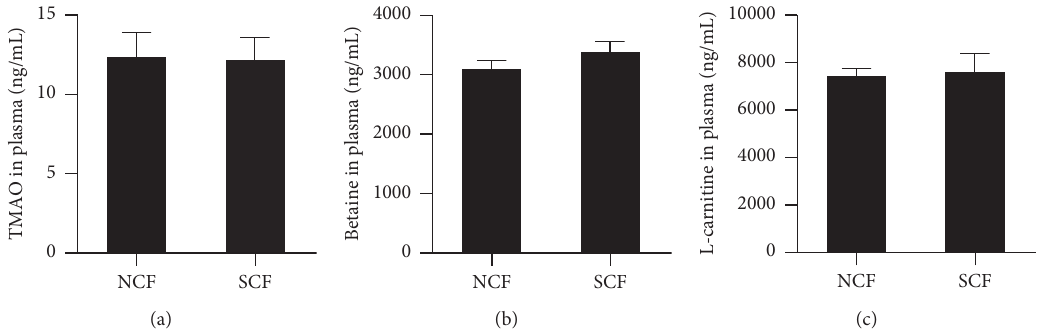
Figure 5: Plasma Trimetylamine-oxide (TMAO), L-carnitine, and betaine levels in the NCF group and SCF group. (a) Plasma TMAO concentration in patients with NCF and SCF, (b) plasma betaine level in patients with NCF and SCF, and (c) plasma L-carnitine level in patients with NCF and SCF. Data were expressed as mean ± standard error of the